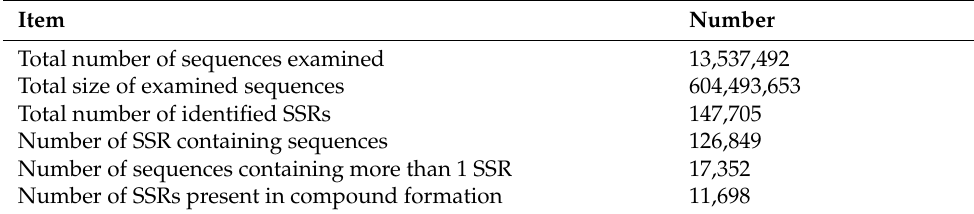
Table 5. Detection results of SSR loci in H. leucisculus .